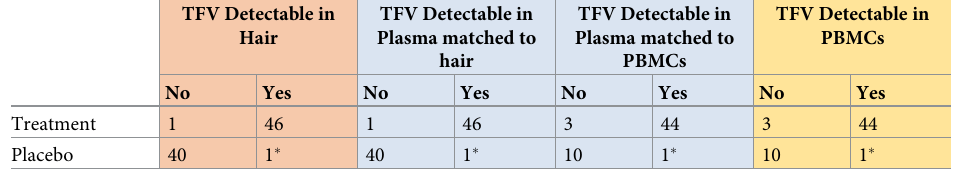
concurrently, 46/47 (97.9%) active arm participants had detectable TFV in both matrices. When PBMCs and plasma samples were obtained concurrently, 44/47 (93.6%) active arm participants had detectable TFV-DP and TFV, respectively. Table 3 shows Spearman corre- lation coefficients for each measure of adherence or drug exposure against all other mea- sures in the study and Fig 2 shows the scatterplots for the biological measures. Spearman correlation coefficients ranged between 0.34 and 0.59 for pharmacologic measures, and was highest for plasma and PMBCs. In general, the non-biological measures (self-report using VAS measured by ACASI, announced pill count, and MEMS) were moderately correlated with each other. Self-reported adherence using VAS measured by ACASI was poorly Table 2. Detection of tenofovir in hair, plasma and peripheral blood mononuclear cells in active and placebo par- ticipant arms in the US CDC PrEP safety study. TFV Detectable in TFV Detectable in TFV Detectable in TFV Detectable in Hair Plasma matched to Plasma matched to PBMCs hair PBMCs No Yes No Yes No Yes No Yes Treatment Placebo 1 (cid:3) 10 1 (cid:3) TFV = tenofovir; PBMC = peripheral blood mononuclear cells; (cid:3) tenofovir detected in the same individual, on the same date, in the placebo arm across all three biomatrices